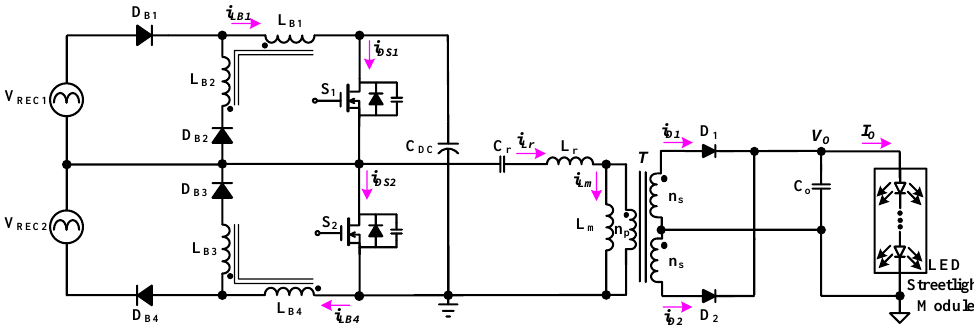
Figure 3. The simplified circuit of the presented single-stage LED driver for streetlight applications.